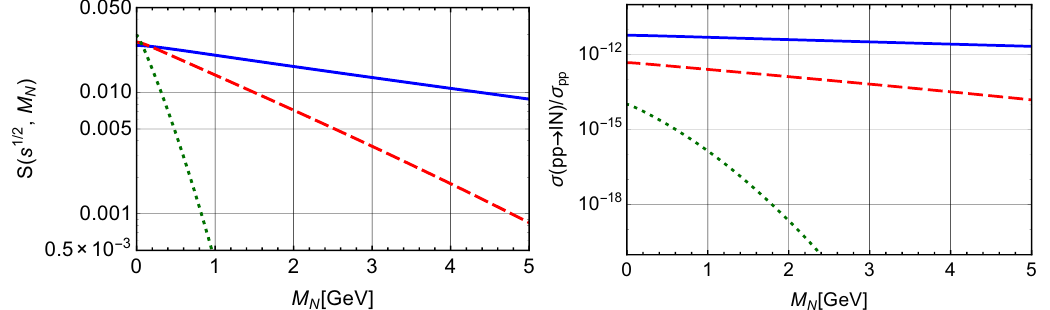
Figure 8 . Integral (2.13) as a function of HNLs mass, neglecting lepton mass (left panel) and Probability of HNL production in p - p collision for line), p s = 28 GeV (red dashed line) and p s = 4 GeV (green dotted line). The suppression of the integral as compared to M N = 0 case is due to PDFs being small at x x 1 x 2 s > M 2 . Total p - p cross section is taken from N